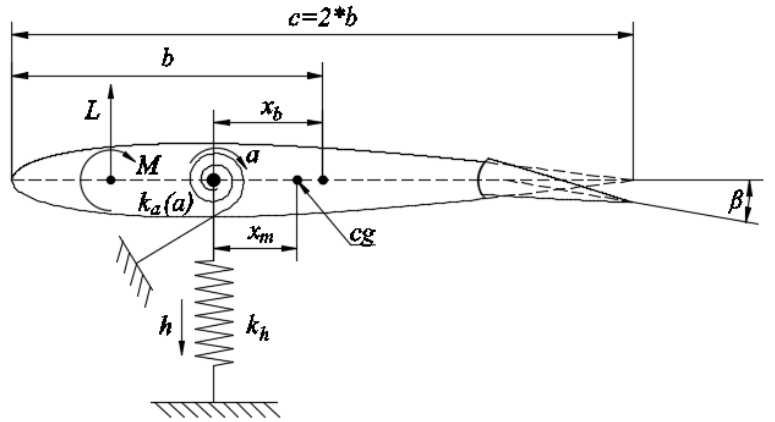
Figure 3. Typical two-dimensional wing section with control surface.